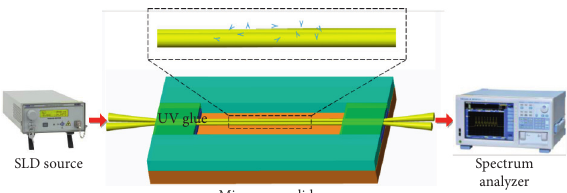
Figure 2: Schematic diagram of the embedded MFG and exper- imental